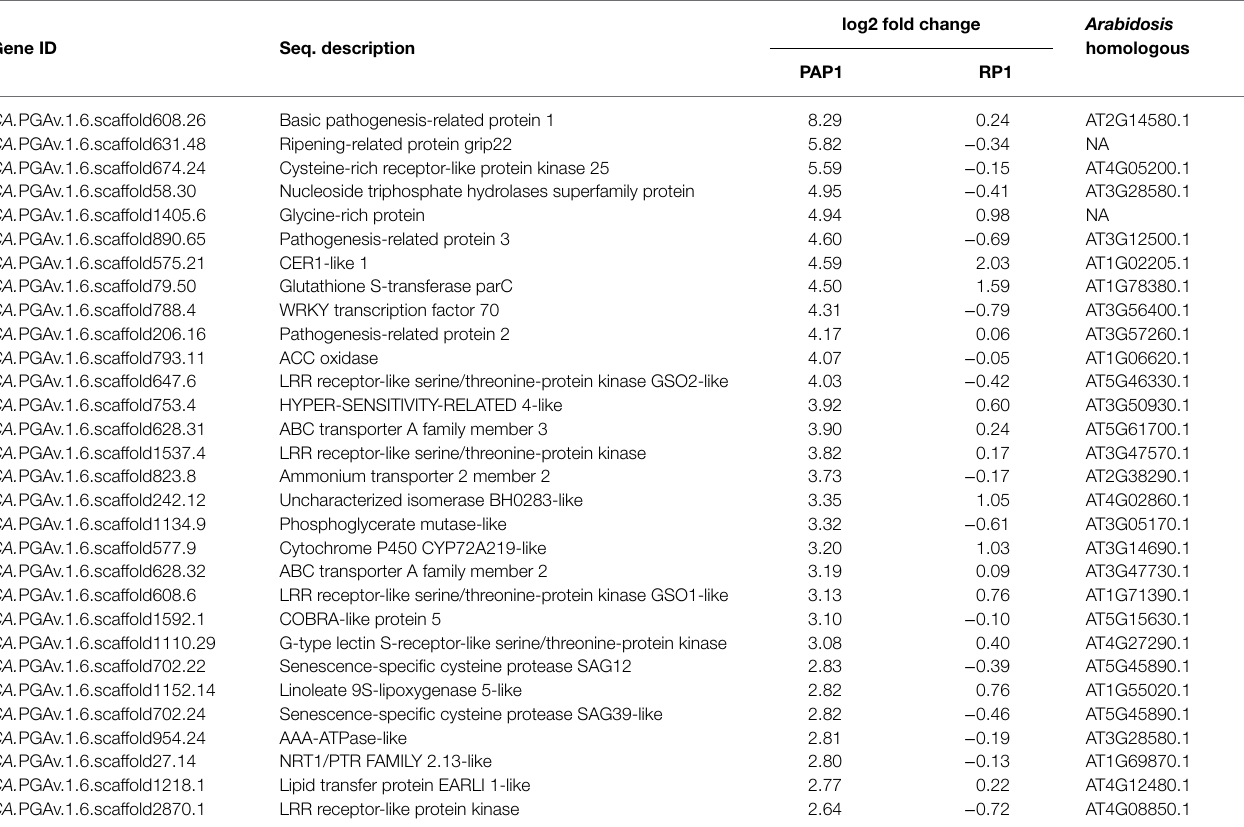
log2 fold change Arabidosis